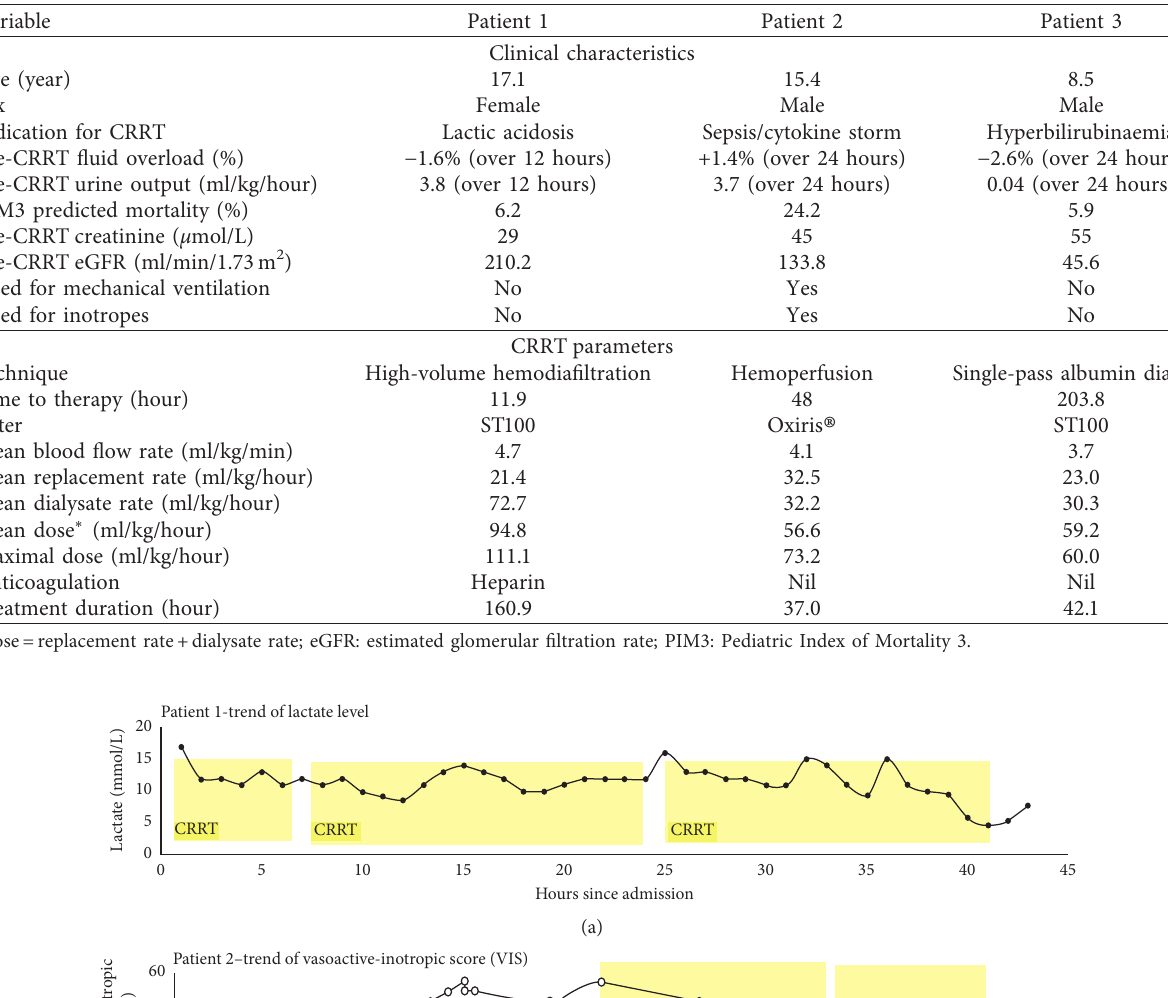
Table 1: Clinical characteristics and continuous renal replacement therapy (CRRT) parameters of the three